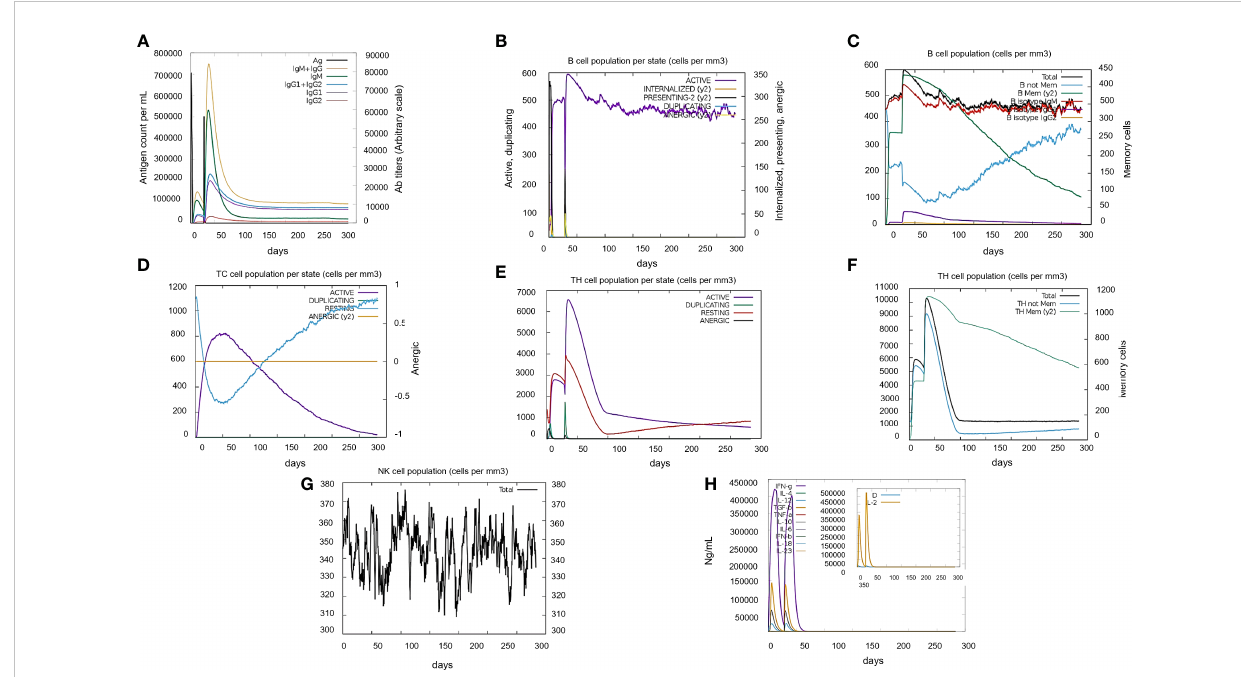
FIGURE 4 Immune simulation pro fi le of vaccine construct (V7) in two injections by C-immsim server. (A) High primary response of IgM and IgG antibodies by antigen exposure. (B) B-cells immune reaction where active B-cells are produced in constant amount after second injection. (C) Total B-cell antibodies immune response. (D) Cytotoxic T-cells immune reaction with high active T-cell production. (E) Helper T-cell response with signi fi cant increase at second injection. (F) Total Helper T-cells immune response. (G) Natural Killer immune cells pro fi le. (H) Simpson Index D graph representing cytokines and Interleukin levels where “ D ” indicates the danger